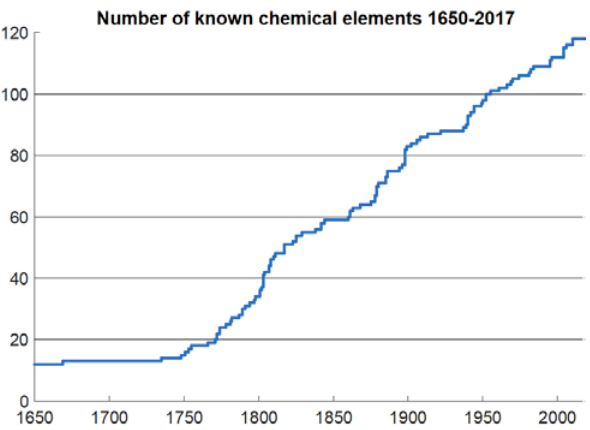
Figure 1. Discoveries of chemical elements since 1650. Source: htt- ps://commons.wikimedia.org/wiki/File:Known-elements-1650-pre- sent.png